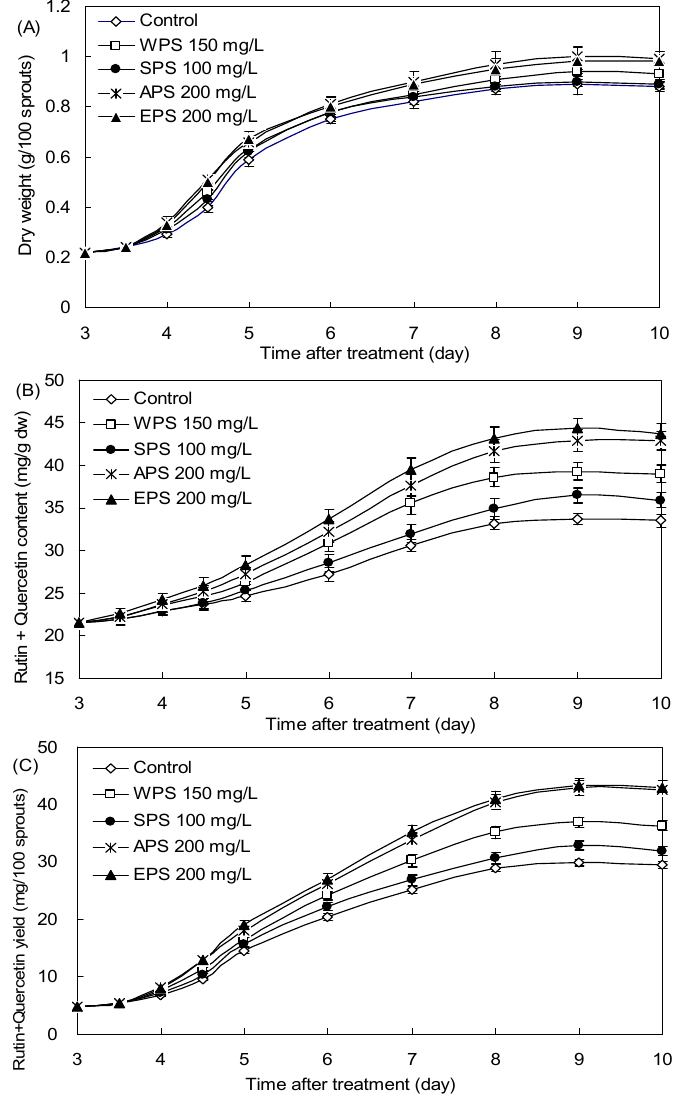
Figure 5. Kinetic studies of sprout growth ( A ), rutin and quercetin accumulation ( B ), and rutin and quercetin production ( C ) of tartary buckwheat after treatment with 150 mg/L of WPS, 100 mg/L of SPS, 200 mg/L of APS and 200 mg/L of EPS of endophyte F. oxysporum Fat9 in comparison with the control culture ( n = 3).